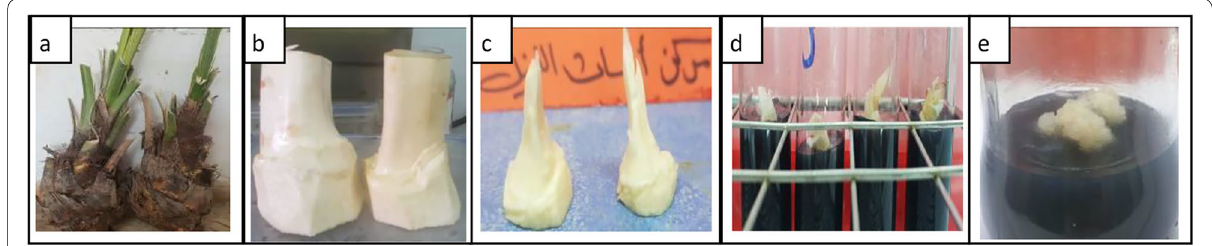
Fig. 1 Induction of callus of date palm ( P. dactylifera L. cv. Barhee) from apical buds of an offshoot: a offshoots, b trimmed offshoots, c apical buds, d quarters of apical buds on MS medium, e callus formation ( ×